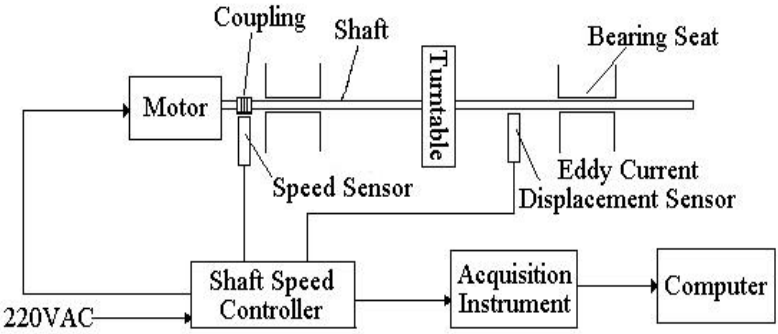
Figure 16. The schematic diagram of the test system.